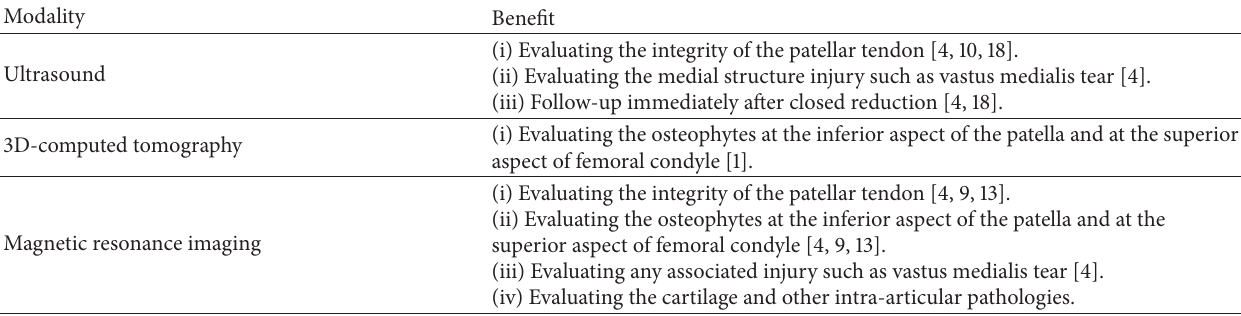
Table 1: Additional imaging